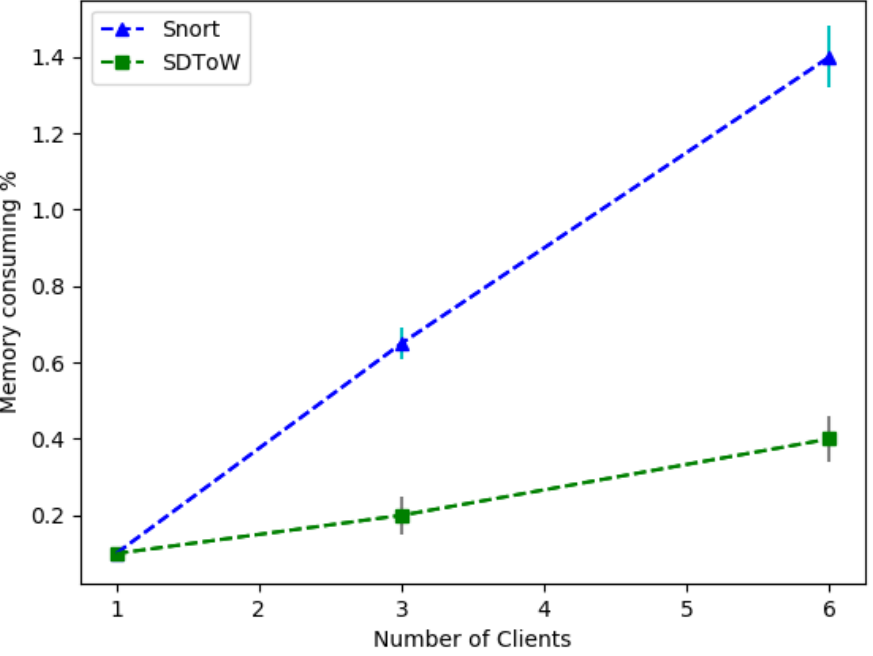
Figure 12. Memory consumption comparison between Snort and